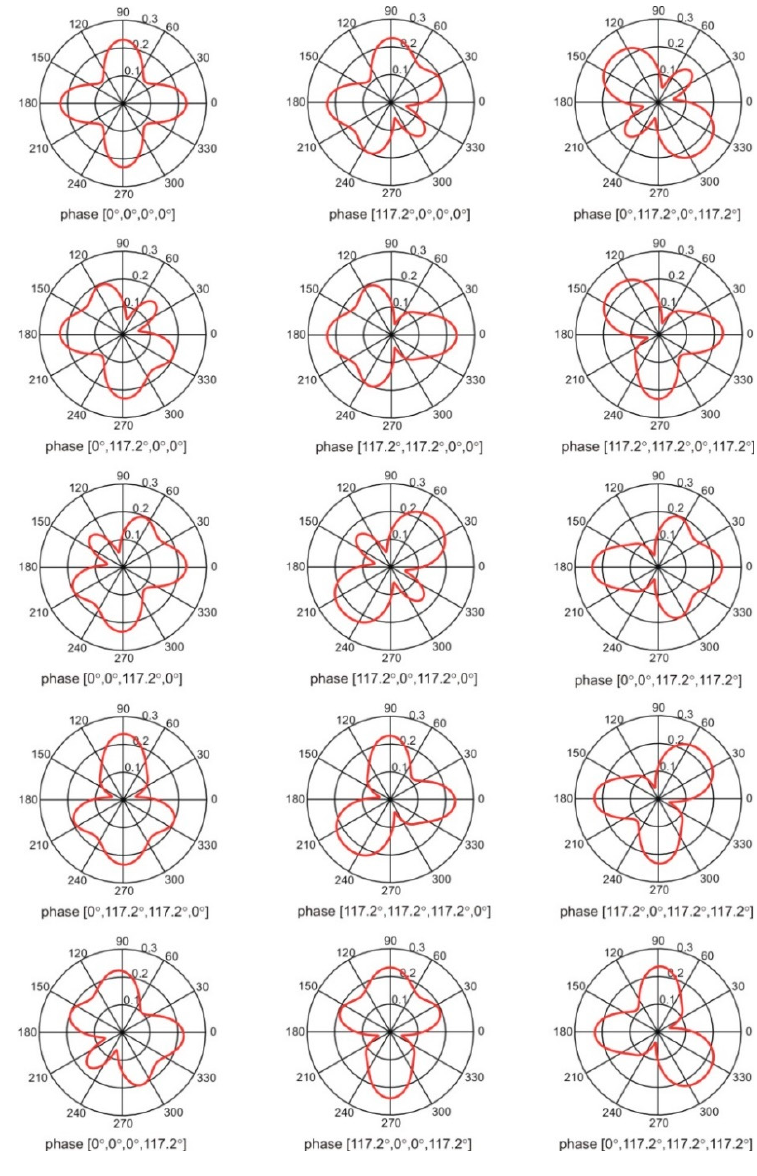
Figure 16. The radiation patterns of the optimized antenna array for all combinations of phasing.